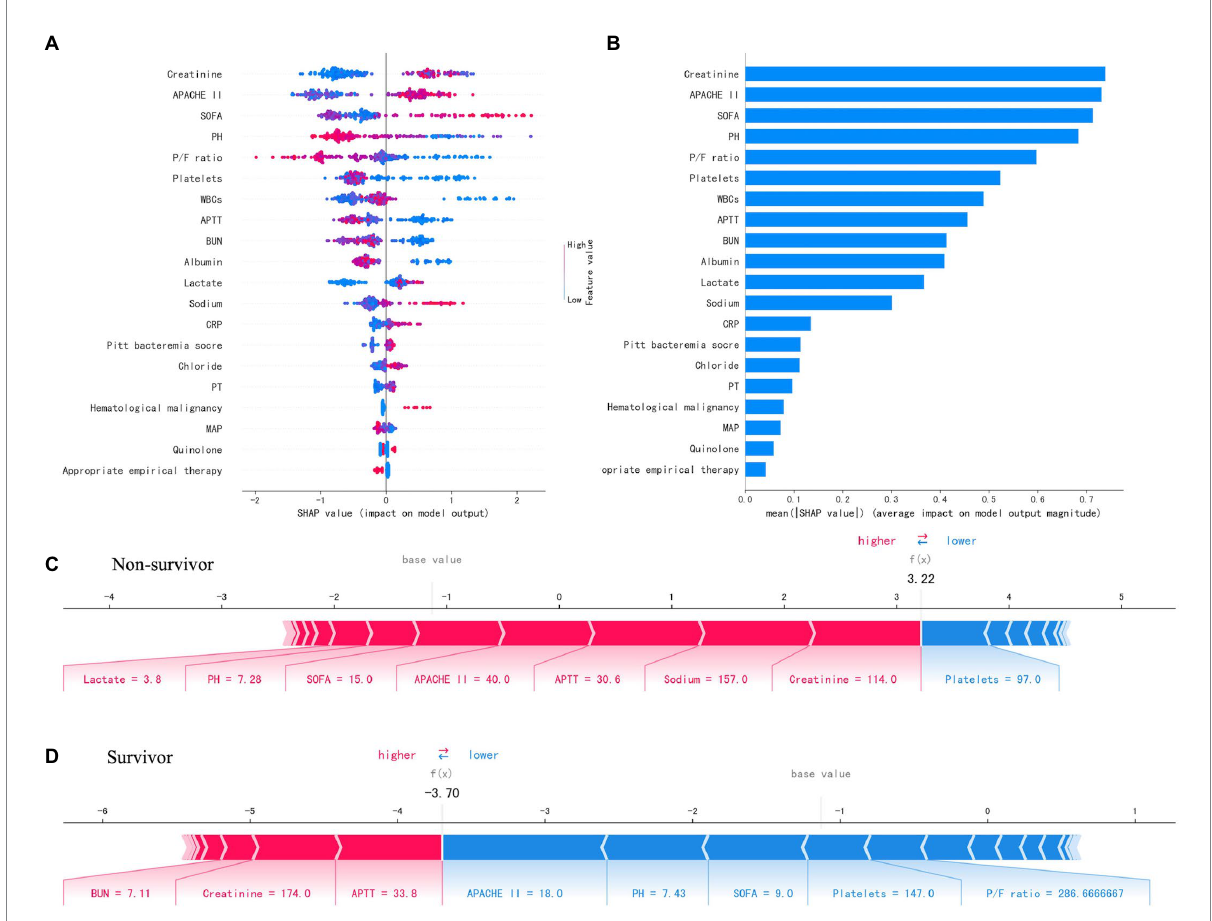
FIGURE 2 Feature analysis of the XGboost model. (A) A summary plot of the SHAP values for the top 20 features of our model. (B) The importance ranking of the top 20 variables according to the average absolute SHAP value. (C,D) The interpretation of model prediction results with the two samples. APACHE II, Acute Physiology and Chronic Health Evaluation II; SOFA, Sequential Organ Failure Assessment; P/F, PaO 2 /FiO 2 ; WBCs, white blood cells; APTT, activated partial thromboplastin time; BUN, blood urea nitrogen; CRP, C-reactive protein; PT, prothrombin time; MAP, mean arterial pressure.